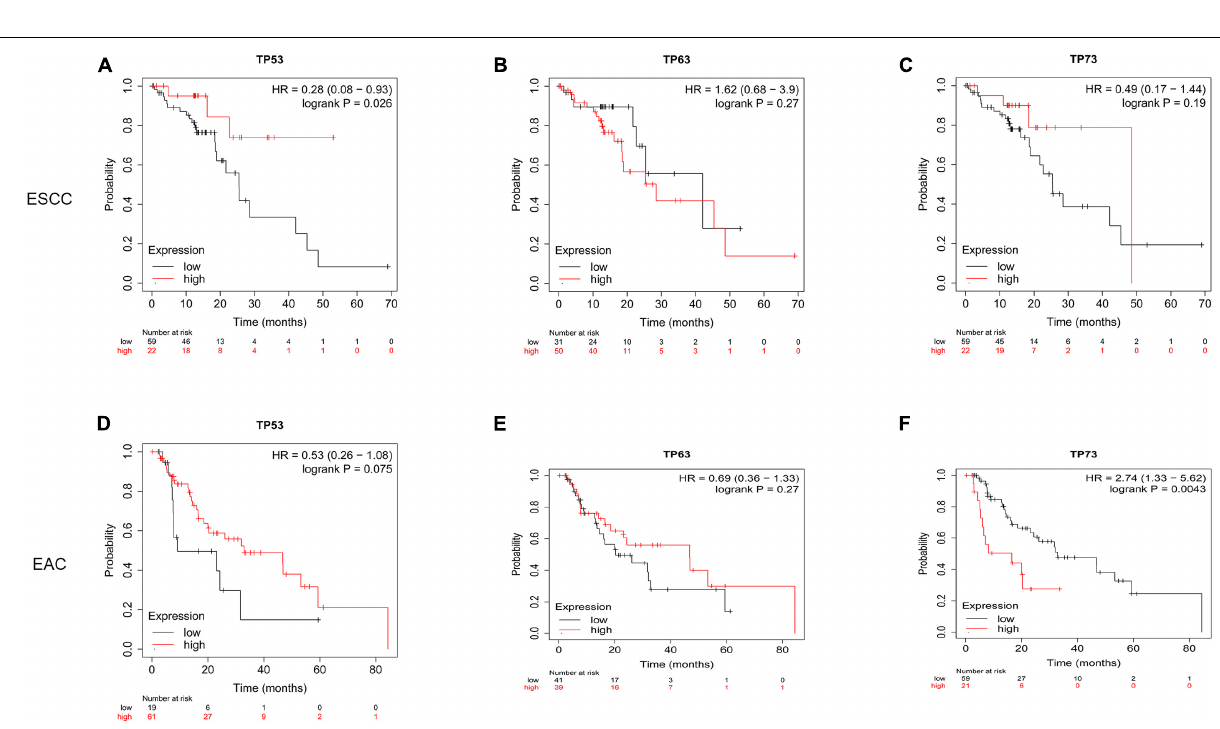
Frontiers in Cell and Developmental Biology |